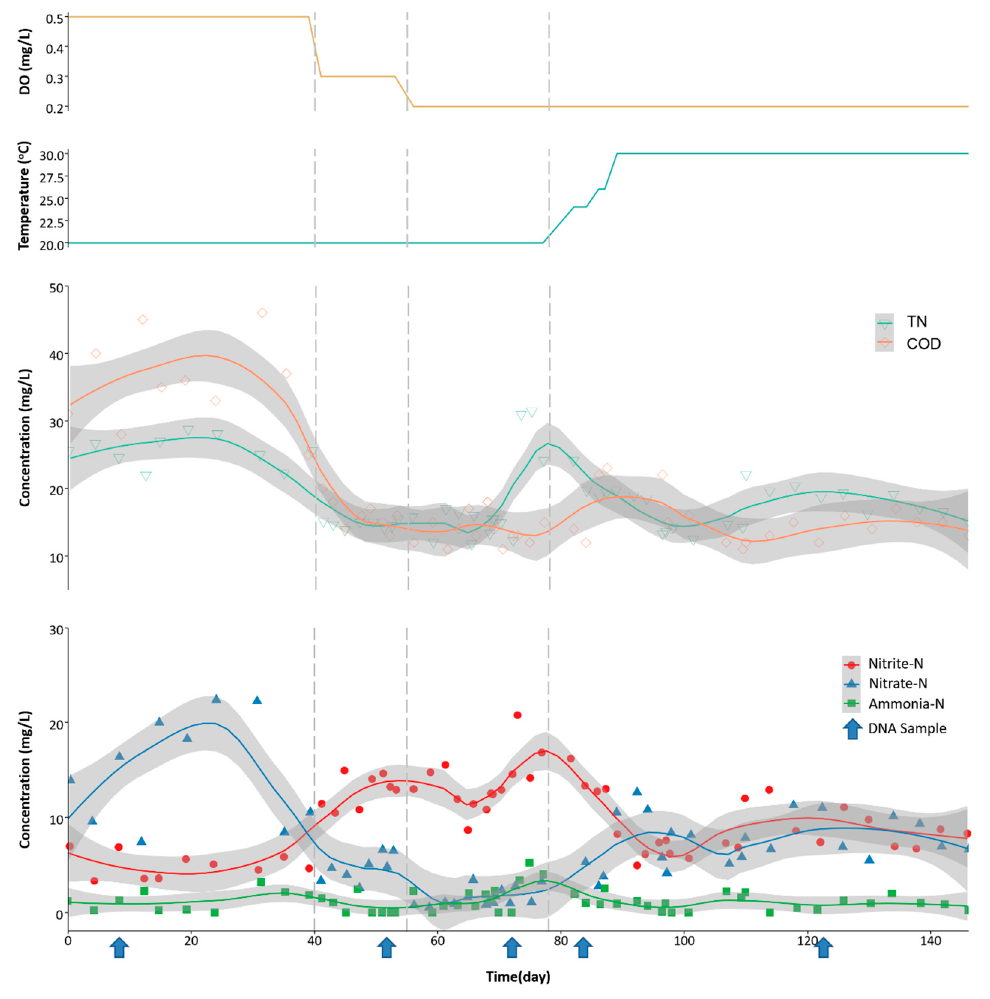
Figure 2. Dissolved oxygen (DO), temperature, and performance of the nitrite shunt system. The yellow line and the green line at the top represent DO and temperature levels. The concentration of nitrogen species and chemical oxygen demand (COD) in the effluent is represented by the scatters. The blue arrows indicate the date of sludge samples collection for 16S rRNA amplicon sequencing. The vertical lines show the separation of each experimental period.